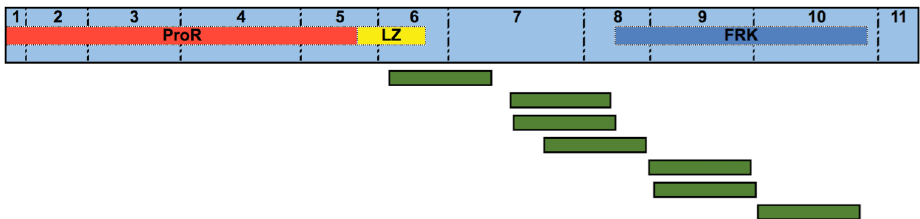
Fig 2. Ground tit foxp3 transcriptome coverage. The 11 numbered exons of the putative ground tit foxp3 sequence annotated with the sequence regions that encode ground tit FoxP3 functional regions. A collection of reads with 100% identity (shown in green) were found with a BLASTN search of ground tit RNA-Seq data from the muscle in the SRA (SRX246872; S2